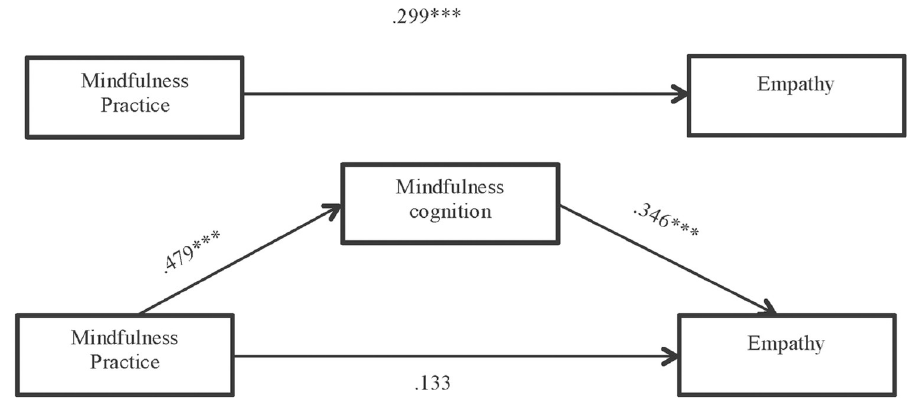
Fig 2. Results of the mediation model: Indirect effect of mindfulness practice on empathy through mindfulness cognition and total effect of independent variable on dependent variable (unstandardized regression coefficients) ��� p <